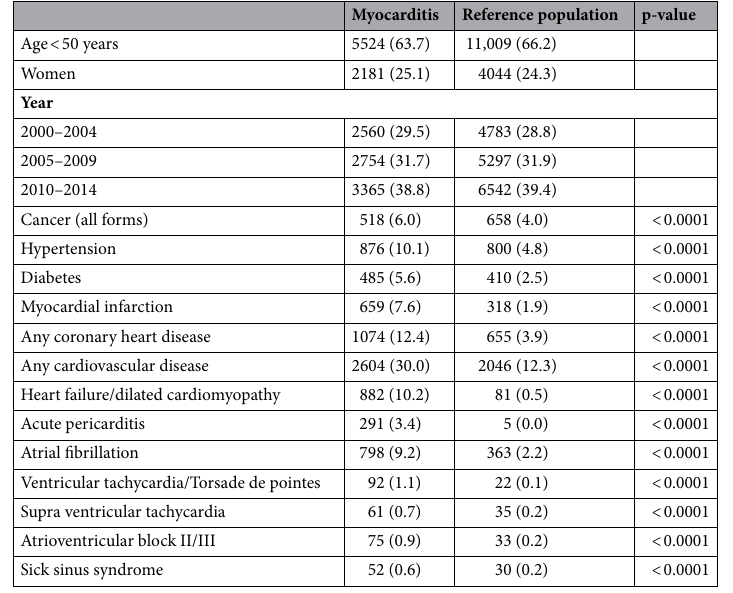
Table 1. Baseline data and comorbidities before the index hospitalization or death. Description of age, gender, incidence period and of relevant comorbidities prior to diagnosis in all individuals with myocarditis in Sweden from 2000 to 2014, as well as in their age and gender matched controls.